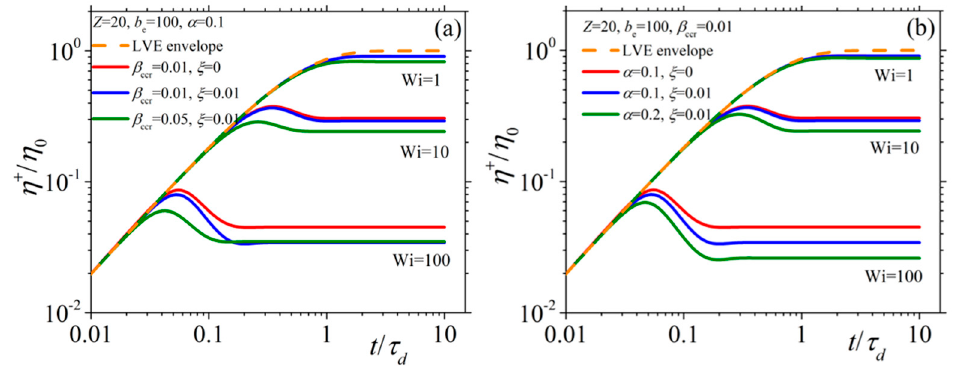
Figure 2. Growth of the shear viscosity upon inception of the shear flow at different dimensionless shear rates for several values of the model parameters ( α , ξ , and β ccr ) when ( a ) keeping α constant, and ( b ) keeping β ccr constant. The LVE envelope is depicted as a dashed orange line.